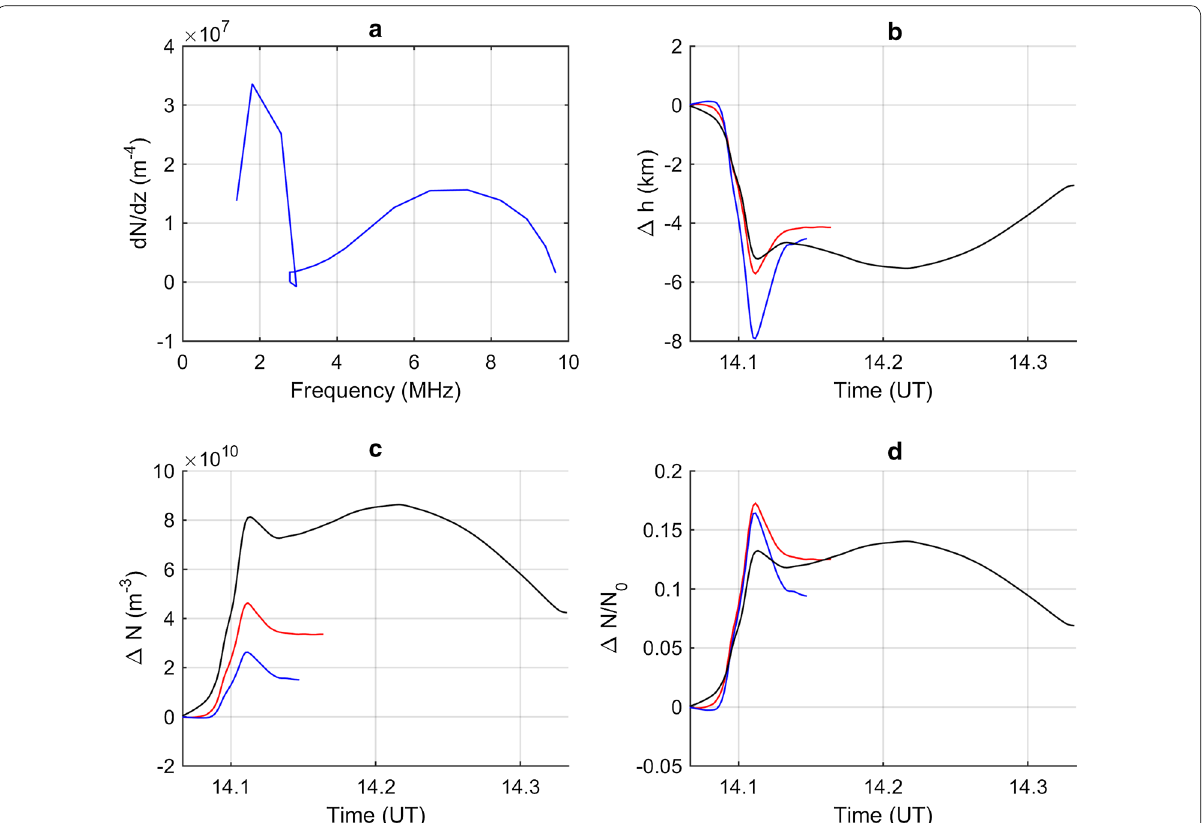
Fig. 5 Electron density gradient and electron density changes. a Electron density gradient as a function of plasma frequency, b fluctuations of reflection heights calculated by Eq. (4) for f 7.04, 4.65, and 3.59 MHz by black, red, and blue, respectively, c electron density change ΔN calculated = by Eq. (7) at the reflection heights for f 7.04, 4.65 and 3.59 MHz by black, red, and blue, respectively. d Relative electron density change related to = the electron density at 14:00 UT on 22 October 2014 (Fig.